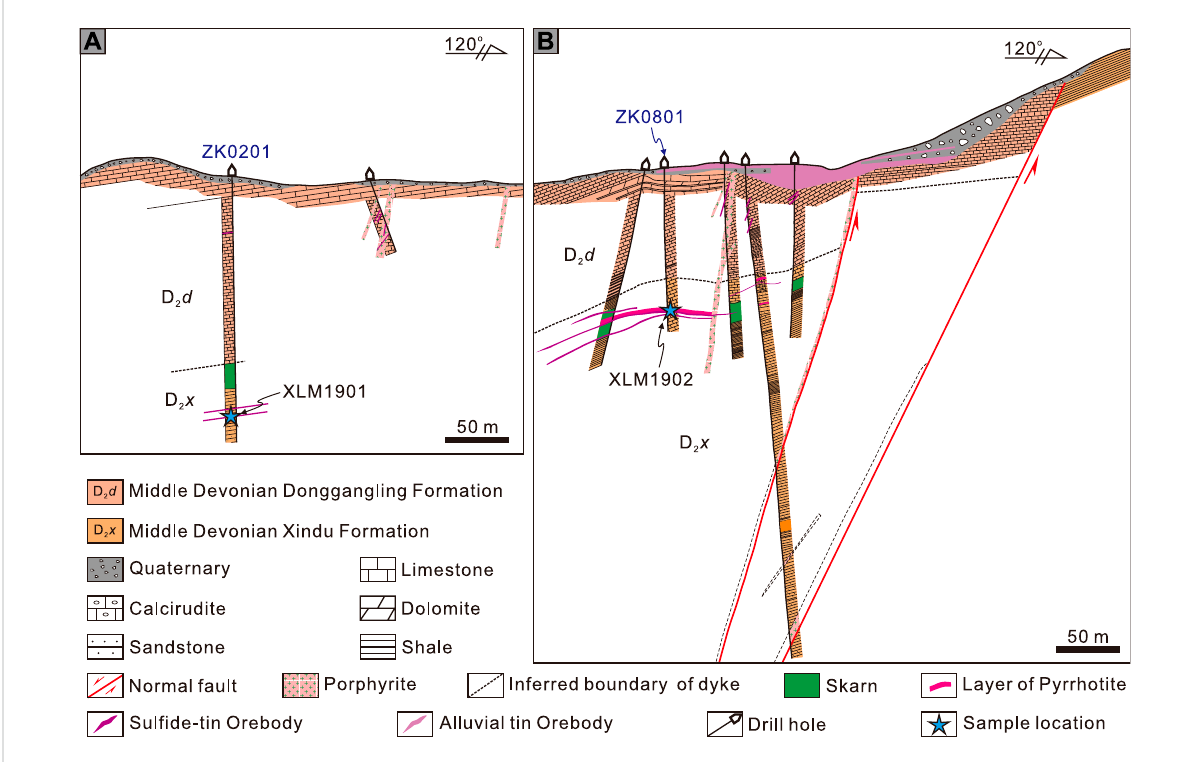
FIGURE 3 Geological cross-section along the No. 2 exploration line (A) and No. 8 exploration line (B) in the Baimianshan segment (modi fi ed after GPIG,